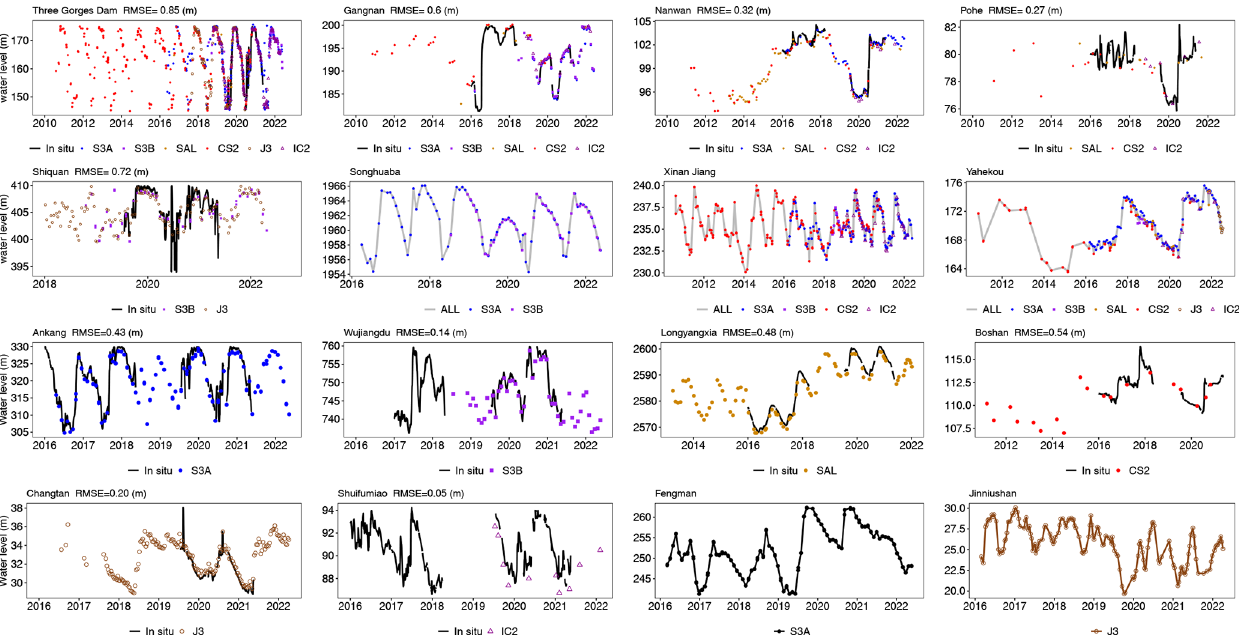
Figure 5. Illustration of SM (standard-measurement) and EM (enhanced-measurement) reservoir water level time series at a selected sample of reservoirs with a varying area size. Time series for other reservoirs are all available in the